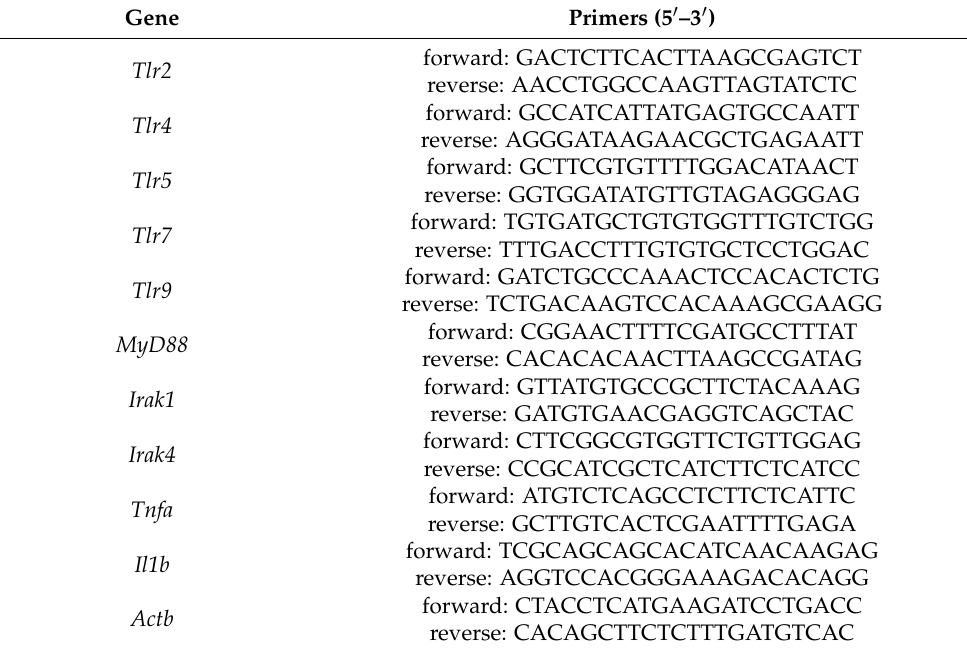
Table 2. Primers used in this study.